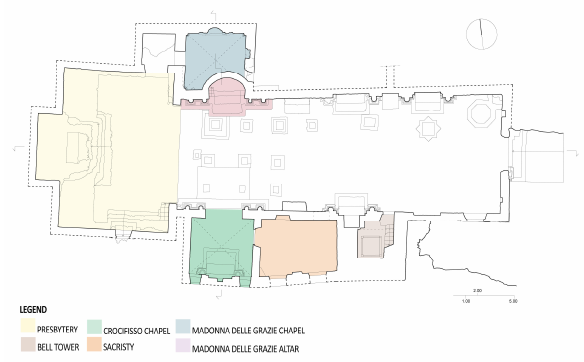
Figure 4. Plan of the church of Santa Maria delle Grazie (ancient Misterbianco)